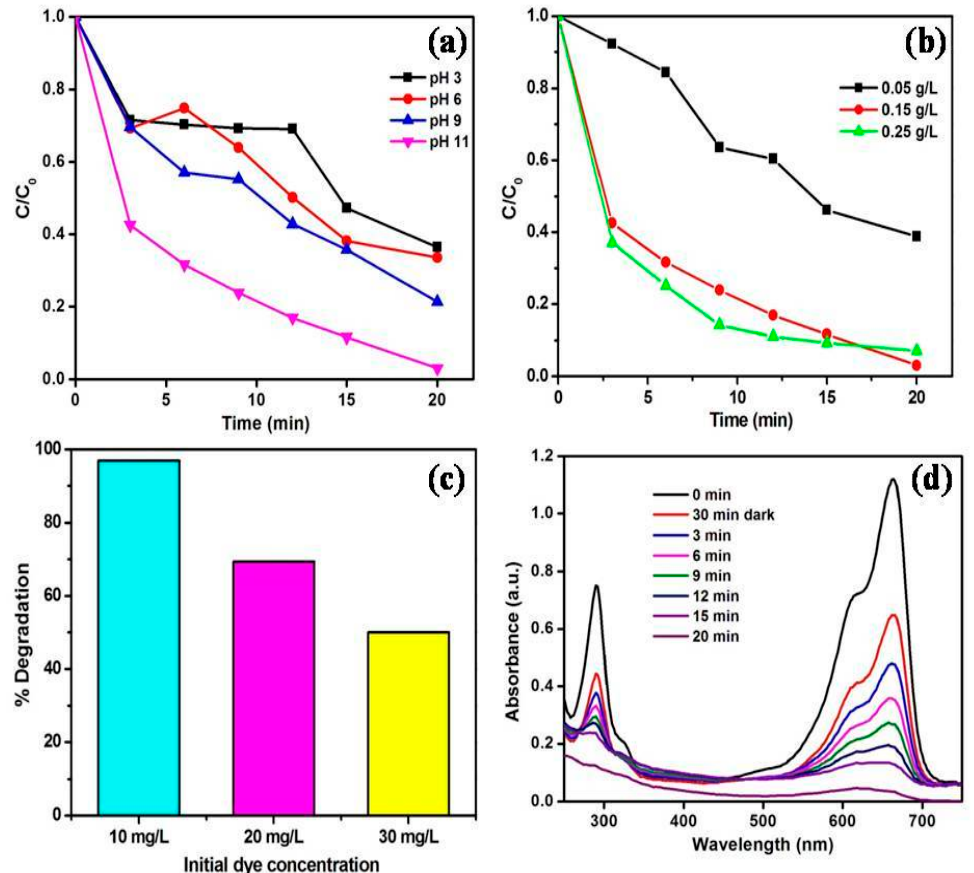
Figure 8. Effect of ( a ) pH; ( b ) catalyst amount; ( c ) initial methylene blue (MB) concentration